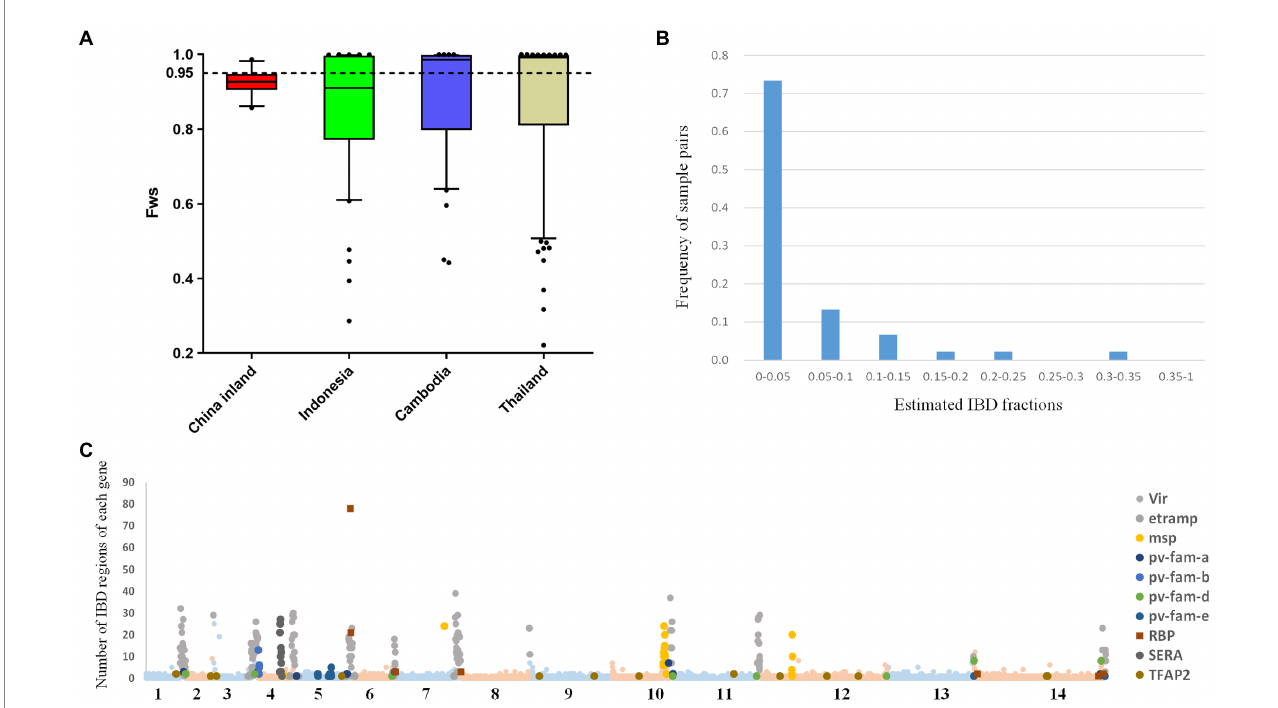
FIGURE 2 F WS and IBD plots illustrate the complexity and relatedness among infections in China’s inland population. (A) Boxplots illustrating different trends in inland, Indonesia, Cambodia, and Thailand. The dotted line illustrates the F WS = 0.95, above which infections are essentially monoclonal. (B) Patterns of identity by descent (IBD) were explored across the genome of China inland and reference populations. The histogram represents the frequency of sample pairs, each pair with IBD fractions above 0.5 should be considered related. (C) 3,431 IBD regions were found and involved 1,157 genes, and 123 genes containing more than 10 IBD fragments including members of multigene families. The x -axis of the scatterplot represents the 14 chromosomes of the parasite and the y -axis represents the number of IBD regions for each